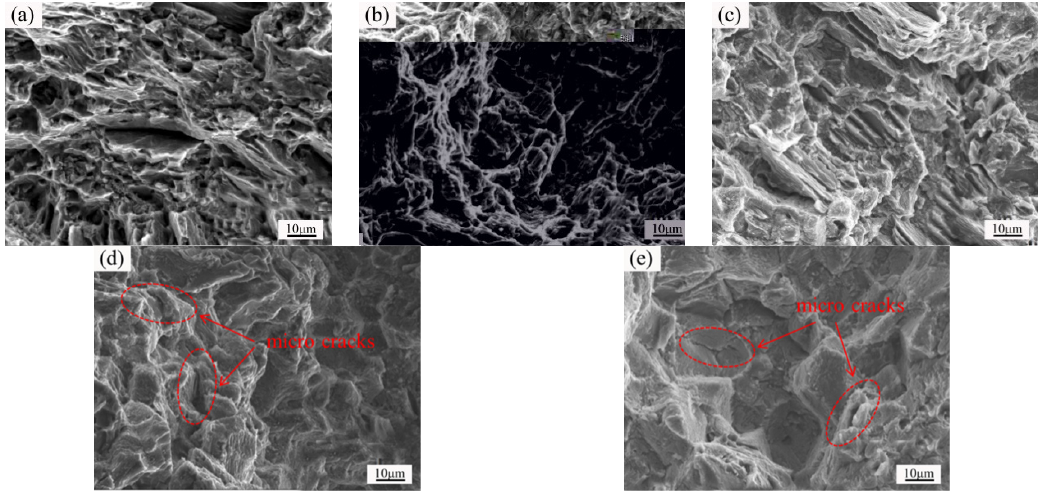
Figure 8. Fracture morphology of the tensile samples with different yttrium contents of: ( a ) Mg-0YL, ( b ) Mg-1YL, ( c ) Mg-2YL, ( d ) Mg-3YL, ( e ) Mg-4YL.